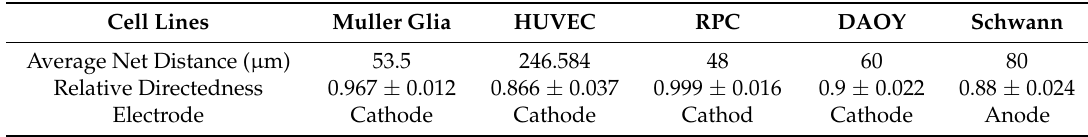
Figure 6. Galvanotactic and chemotactic cell migration of neural cells. ( A ) Average net migration distance of cells in 100 mV/mm electric field. ( B ) Relative number of motile cells in response to Stromal Derived Factor (SDF-1) signaling (100 ng/mL) in transwell migration assays. Table 2. Average Electrotaxis Migration